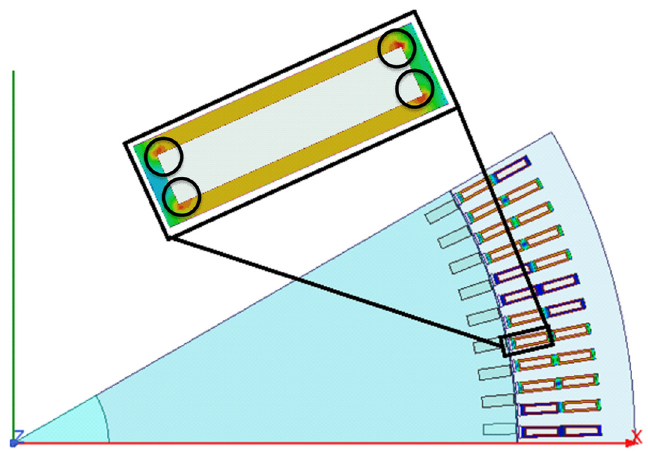
Figure 2. Contour of dielectric stress (V/m) in stator ground-wall insulation .